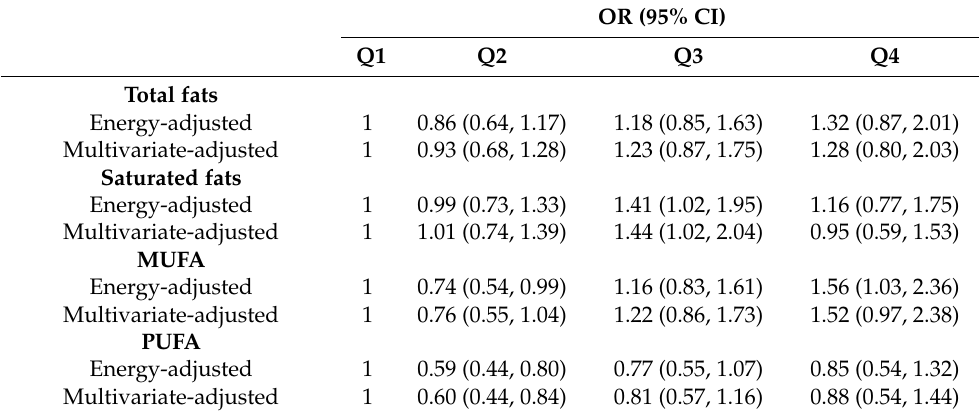
Table 2. Association between total and dietary fat classes and depressive symptoms in the study sample ( n =